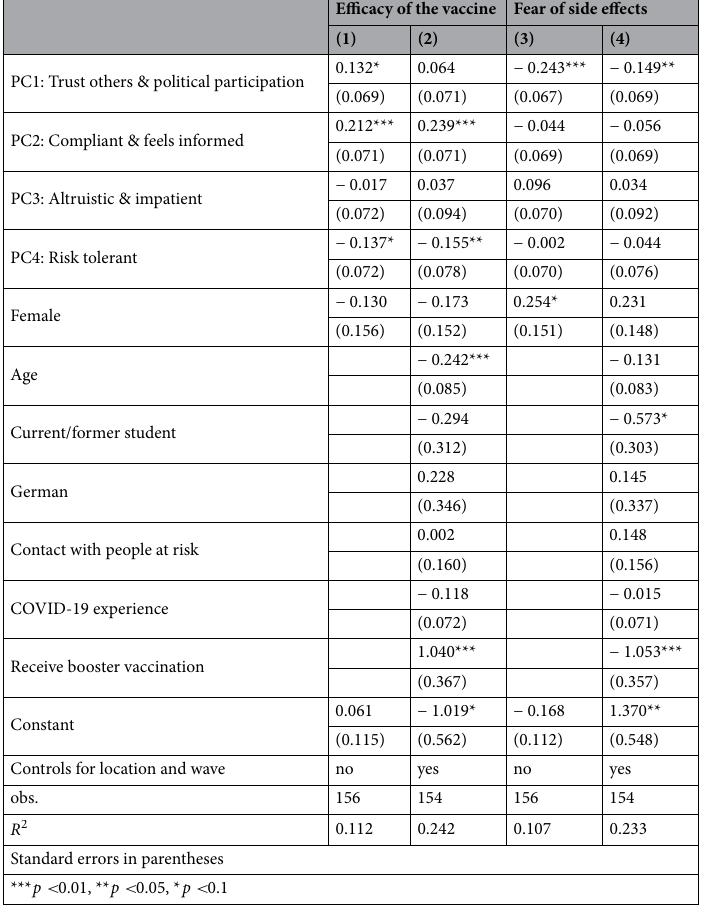
Table 1. OLS regressions on subjects’ trust in the COVID-19